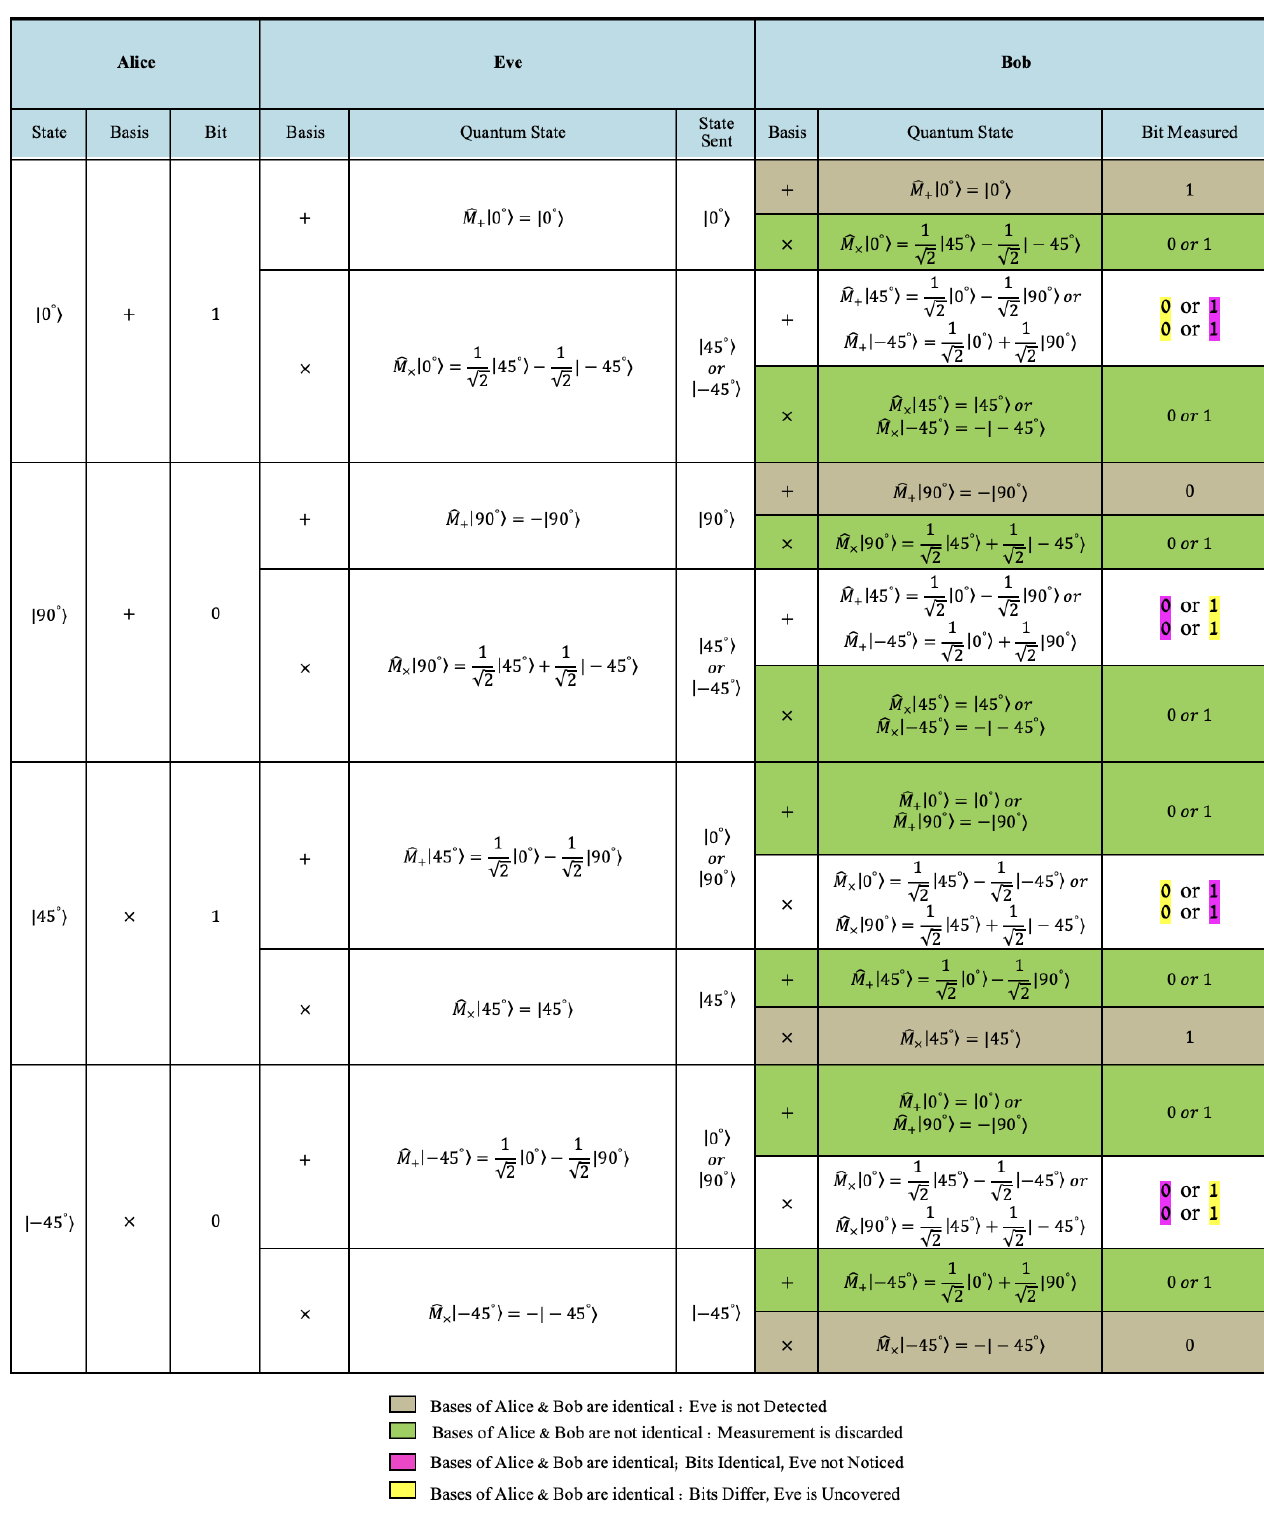
Figure 4. Alice and Bob basis, bits and measured bit—with